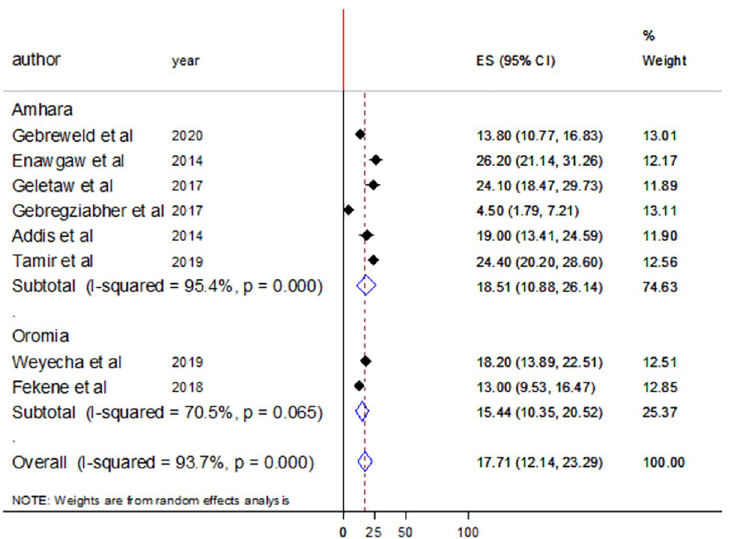
Fig 10. Forest plot showing the pooled prevalence of leucopenia by study